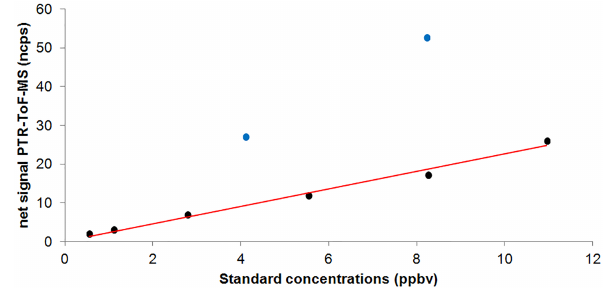
Figure 1. MGLY (black circles) and MEK (blue circles) calibra- tion plot for PTR-ToF-MS measurements: normalized net signals at m/z 73.029 (MGLY, ncps) and 73.065 (MEK, ncps) vs. generated mixing ratio